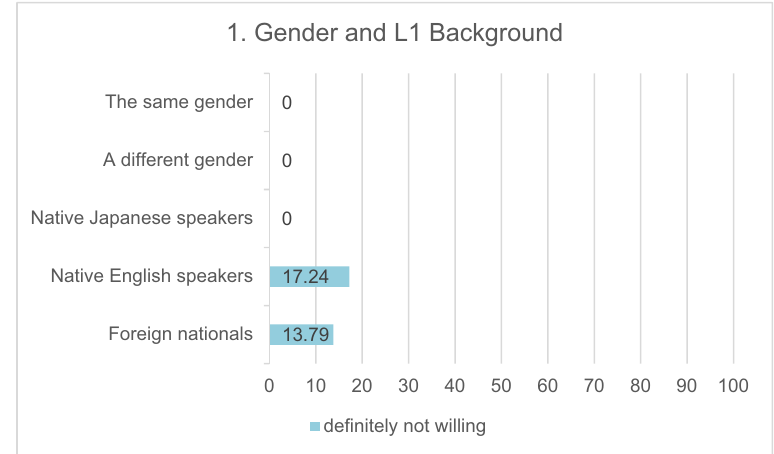
Figure 14: Unwillingness rates under di ff erent Interlocutors in L1 ( % ) .